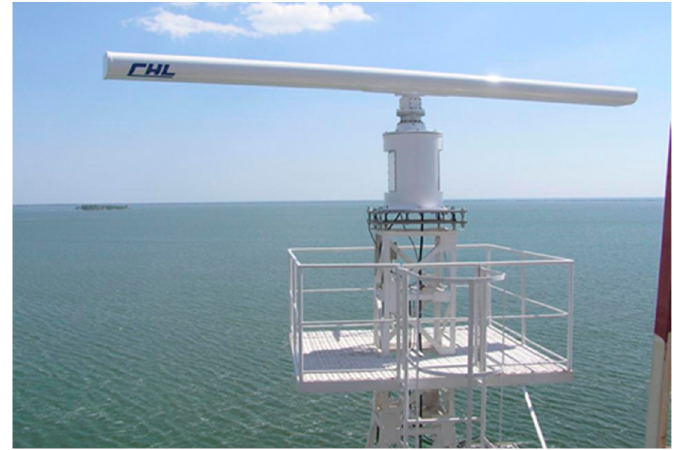
Figure 7. The appearance of the vessel radar [56].